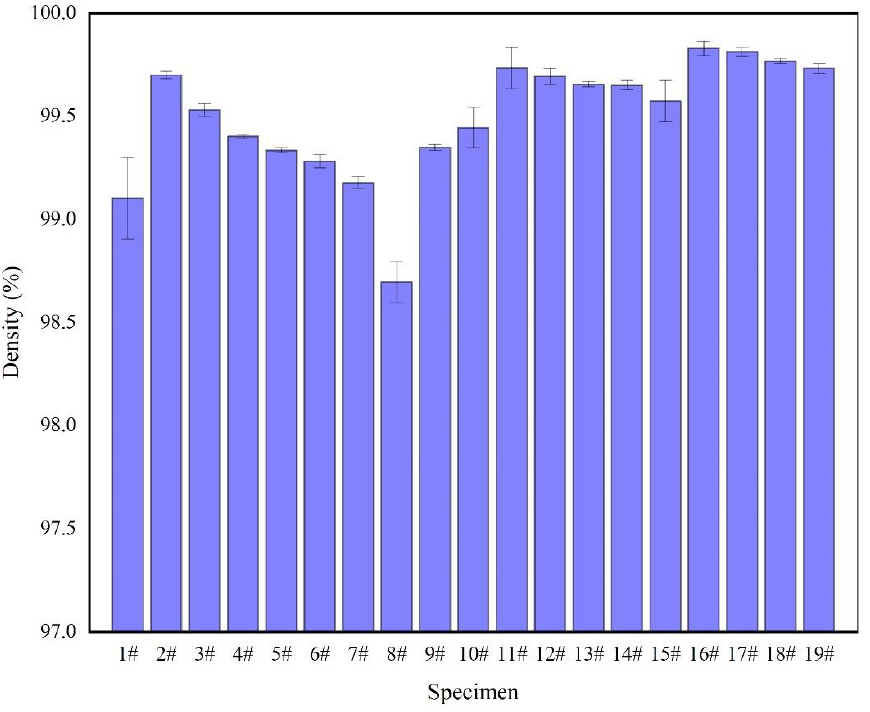
Figure 5. Density measurement results of specimen.